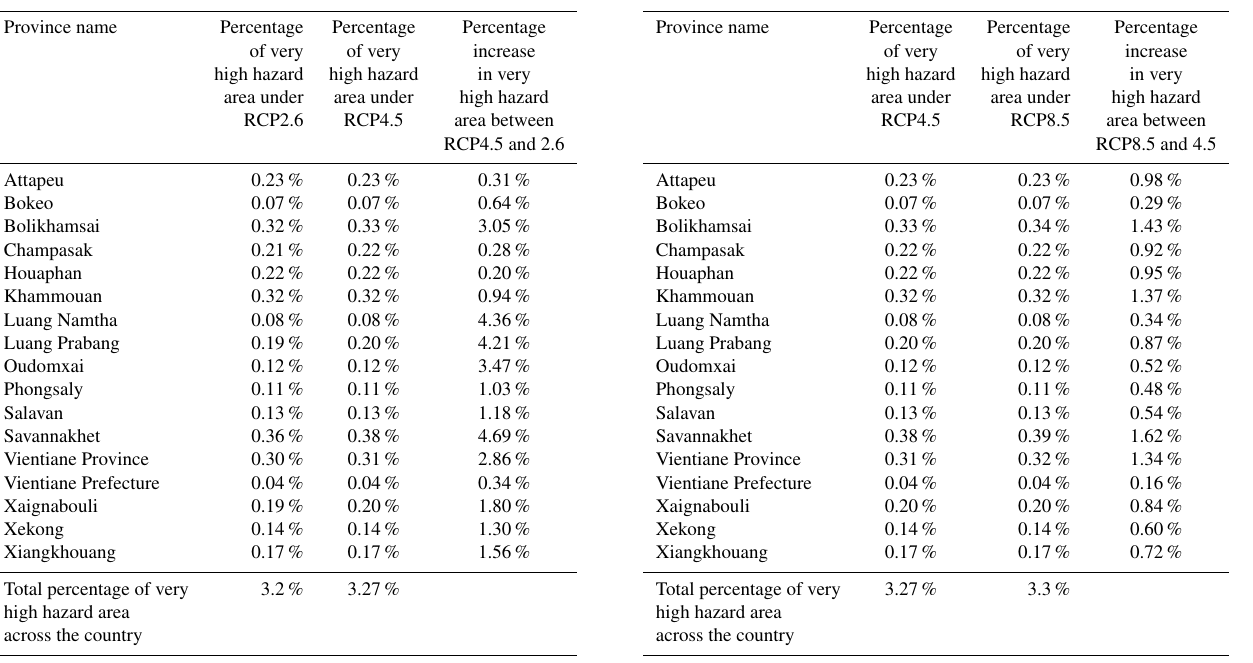
Table 2. Percentage of very high hazard area from the integrated hazard map in each province and the percentage of increase between the RCP4.5 and RCP2.6 scenarios during the near future.